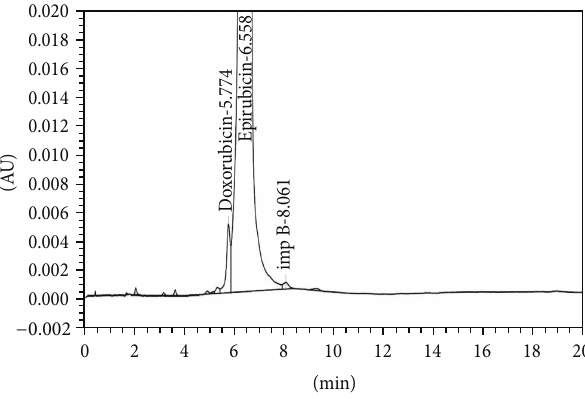
Figure 13: HPLC profile of irradiated epidoxorubicin (25